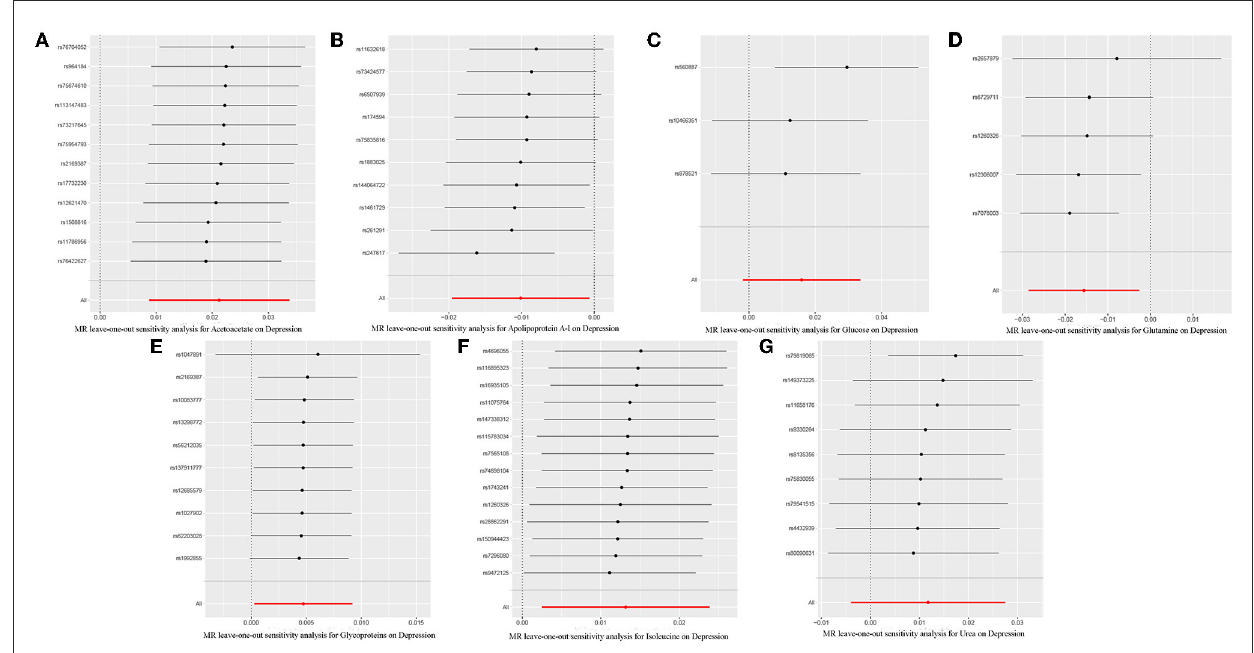
FIGURE5 Leave-one-out plot to visualize the causal effect of each metabolite associated with depression when leaving one SNP out. (A) , Acetoacetate; (B) , Apolipoprotein A-I; (C) , Glucose; (D) , Glutamine; (E) , Glycoproteins; (F) , Isoleucine; (G) , Urea.